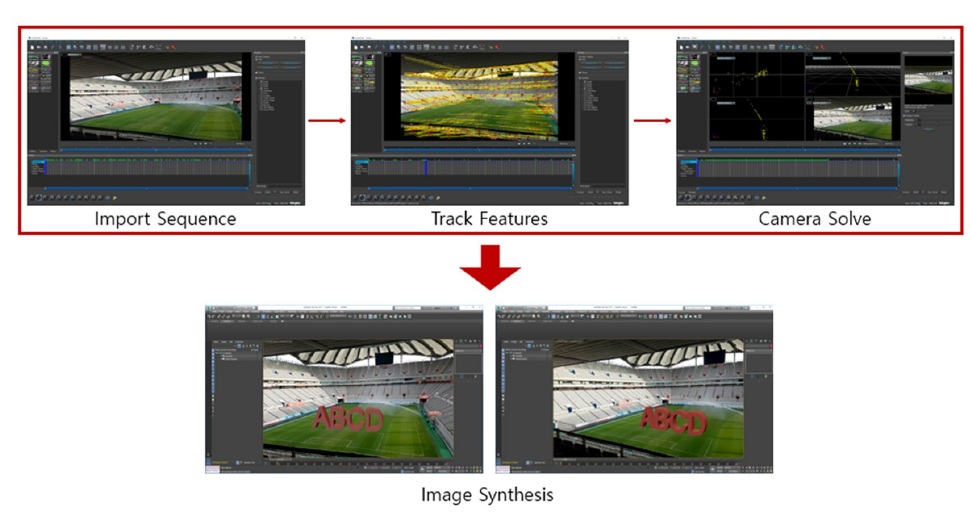
Figure 1. The match-moving process using the Boujou method creating image synthesis by extracting feature points and camera solve from video